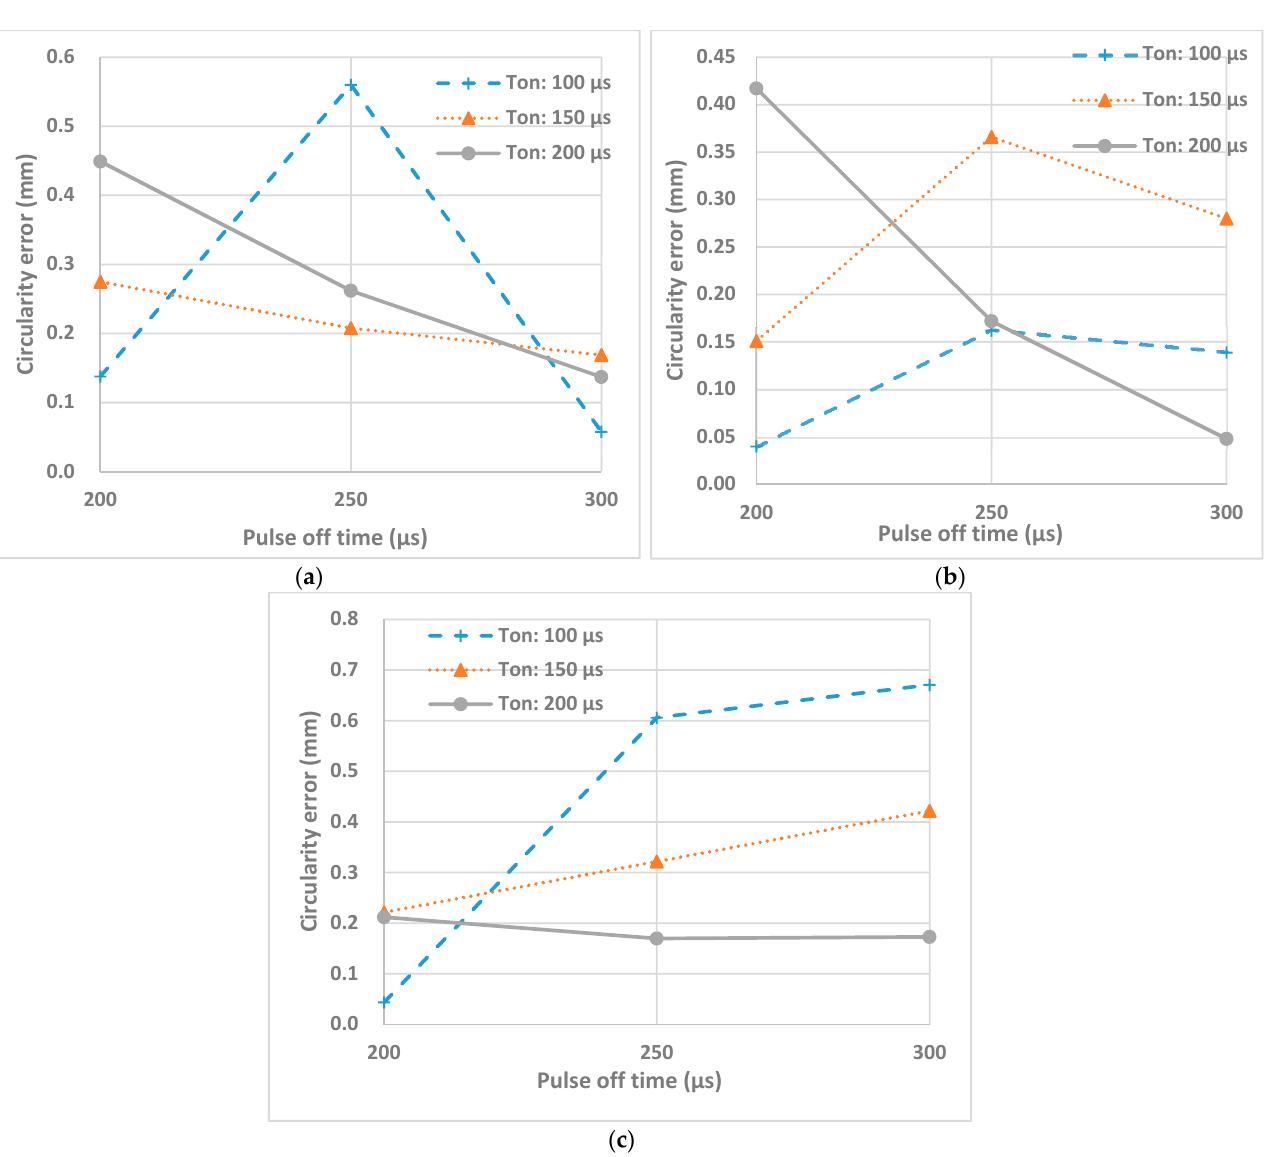
Figure 11. Effects of T on and T off on circularity error at peak currents ( a ) 1 A, ( b ) 3 A, ( c ) 5A. The interaction effects and main effects of process parameters of EDM of nonconduc ‐ tive ZTA on circularity were studied by conducting variance analysis by plotting these effects. In the Figure 12a, the main effect plot for the circularity error can be observed. For each parameter level, the means of circularity error can be seen on this plot. Based on this plot, increasing the peak current from 1 to 3 A, resulted in the decrease of the circularity, which is favorable, however, increasing it from 3 to 5 A resulted the increase of the circu ‐ larity error which is expected since increase in current leads to increase of crater radius and decrease in uniformity of machining. The increase of pulse on time showed only a slight decrease of circularity error. Pulse off time increase shows first sharp increase and after reaching 250 μ s shows sharp decrease. The main effect plots using variance analysis does not indicate specific trends on effect of parameters on the circularity error of the ma ‐ chined holes during EDM of non ‐ conductive ZTA ceramics.